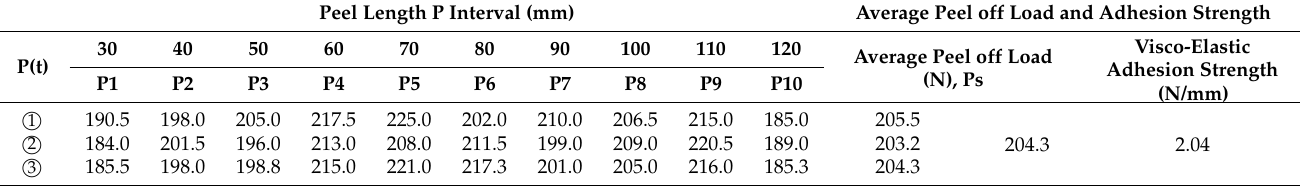
Table 5. VG-1 viscoelastic adhesive strength test results.